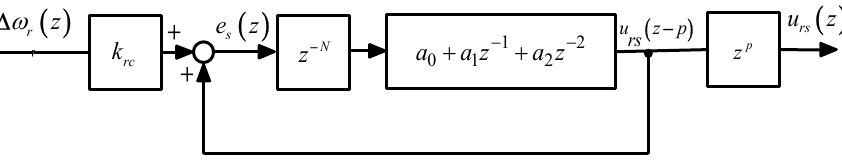
Figure 6. The proposed periodic controller.